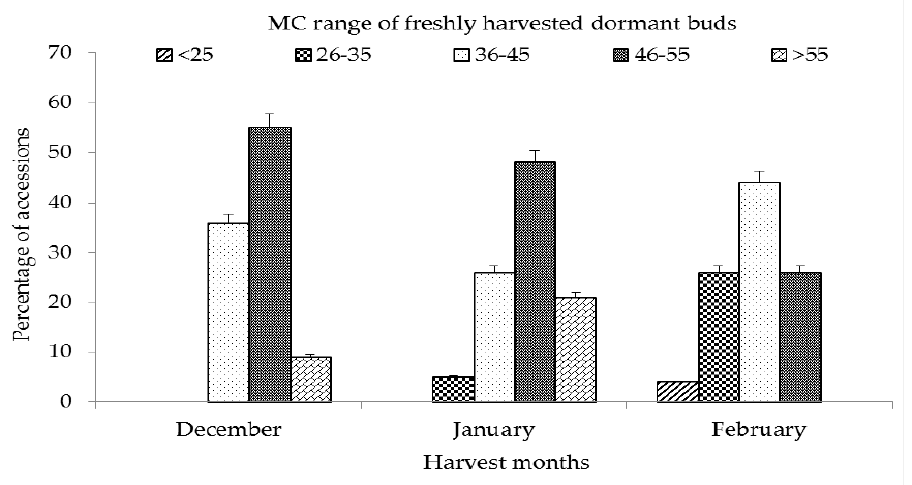
Figure 1. Moisture content (MC%) of dormant buds of different mulberry germplasm harvested in three winter months. MC% values are cumulative of 3 years data. Error bars showing mean values ± SD (n = 3).